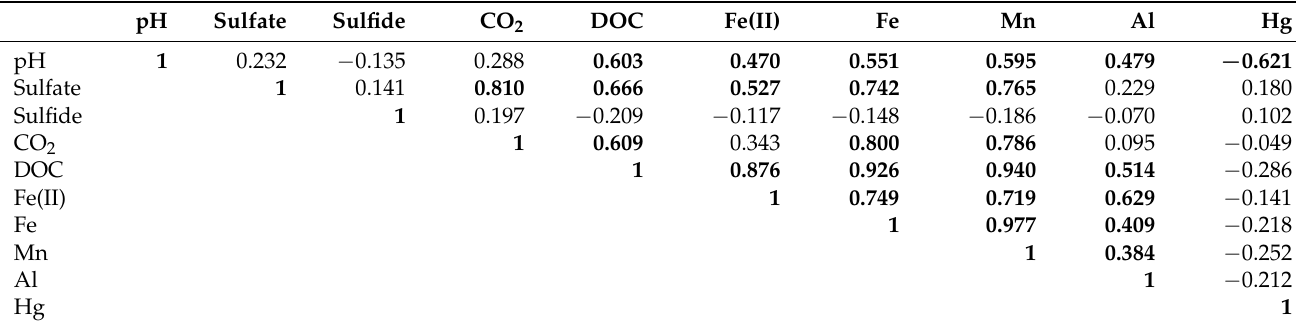
Table 3. Pearson correlation coefficients for the data monitored during anaerobic experiment in the culture medium for all sampling points during the experiment. Values in bold indicate significant differences at the 0.05% critical